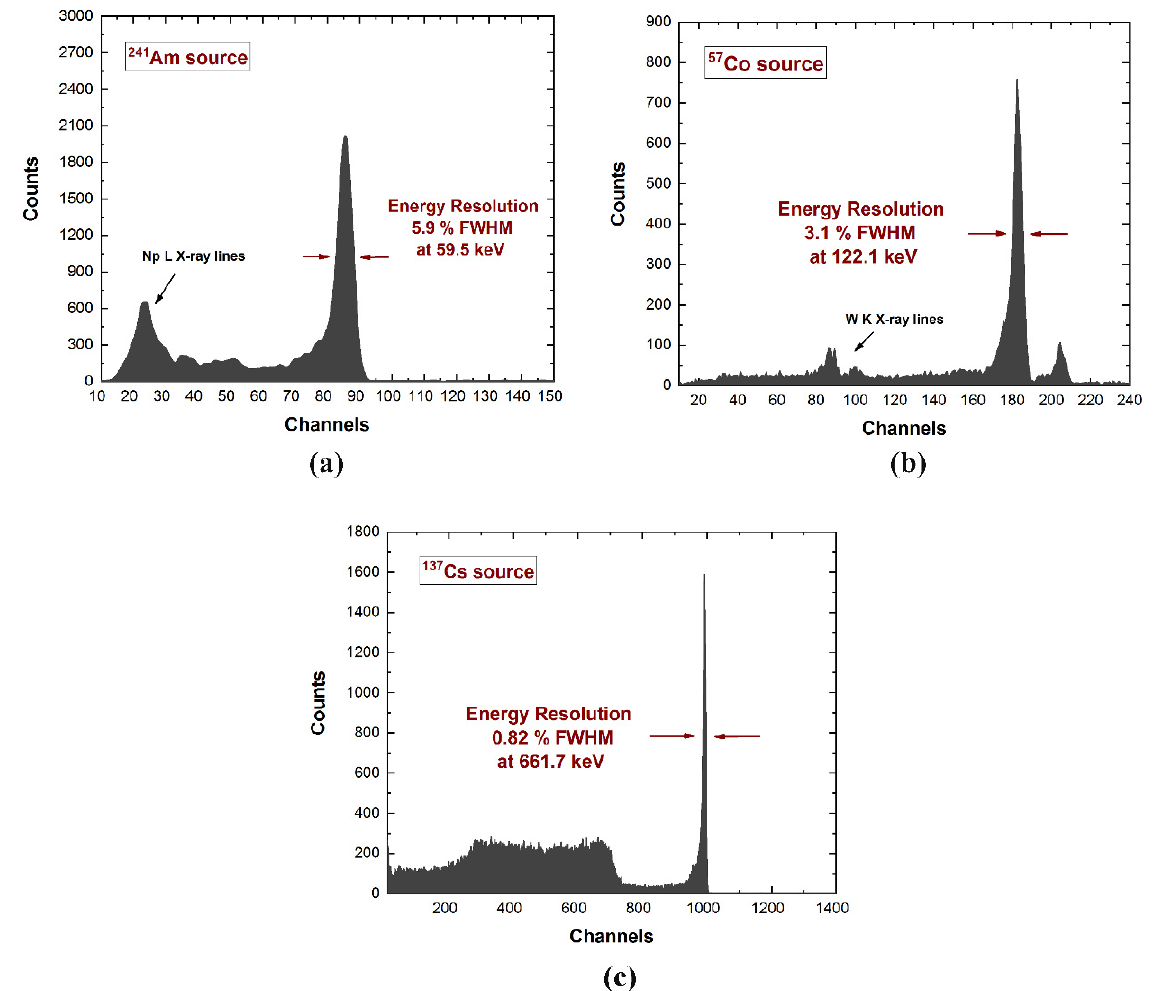
Figure 6. Uncollimated ( a ) 241 Am, ( b ) 57 Co and ( c ) 137 Cs energy spectra measured with the CZT drift strip detectors. The excellent energy resolution was obtained after the application of a novel correction technique using the negative saturation levels from the drift strips [36].